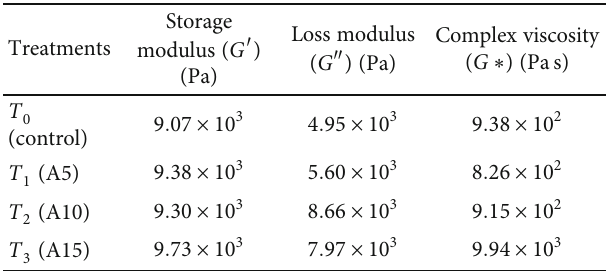
Table 5: E ff ect of amaranth wheat blended dough on rheological properties.